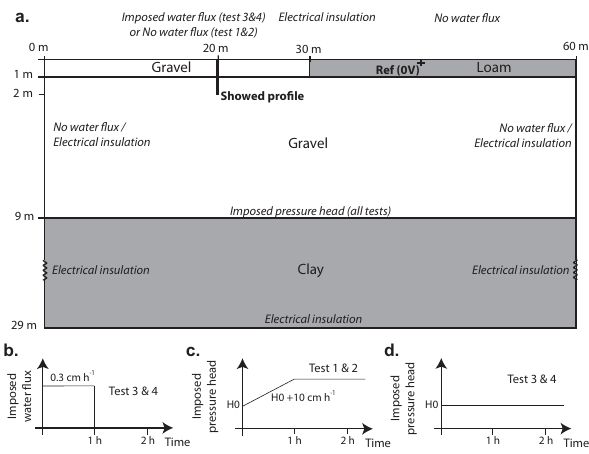
Fig. 7. (a) Conceptual model used to investigate how SP signals vary with respect to variations in the water table (tests 1 and 2) and due to rainfall (tests 3 and 4) for initial water tables at 0.5m (tests 1 and 3) and 1.5m (tests 2 and 4) depth. (b) Imposed infiltration rate in the gravel during tests 2 and 4. Imposed groundwater level fluctuations tests (c) 1 and 2 and (d) 3 and 4,